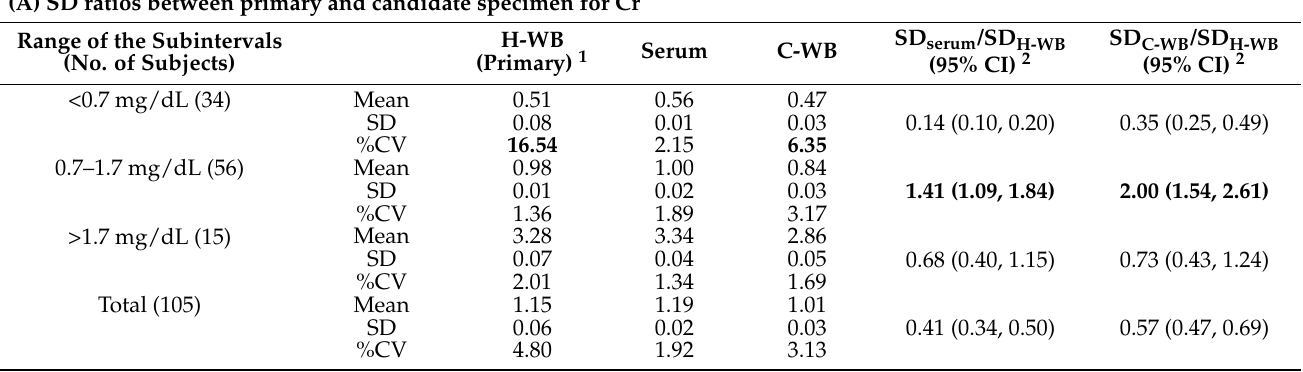
Table 4. Evaluation of precision for equivalence between the primary and candidate specimens in Cr (A) and BUN (B) testing using the ABL90 FLEX